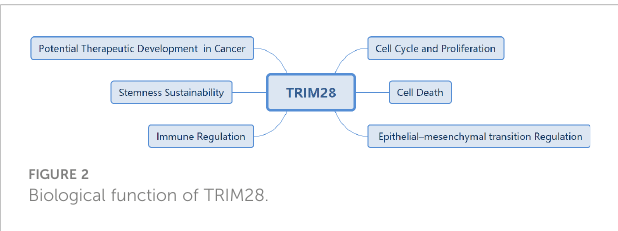
FIGURE 2 Biological function of